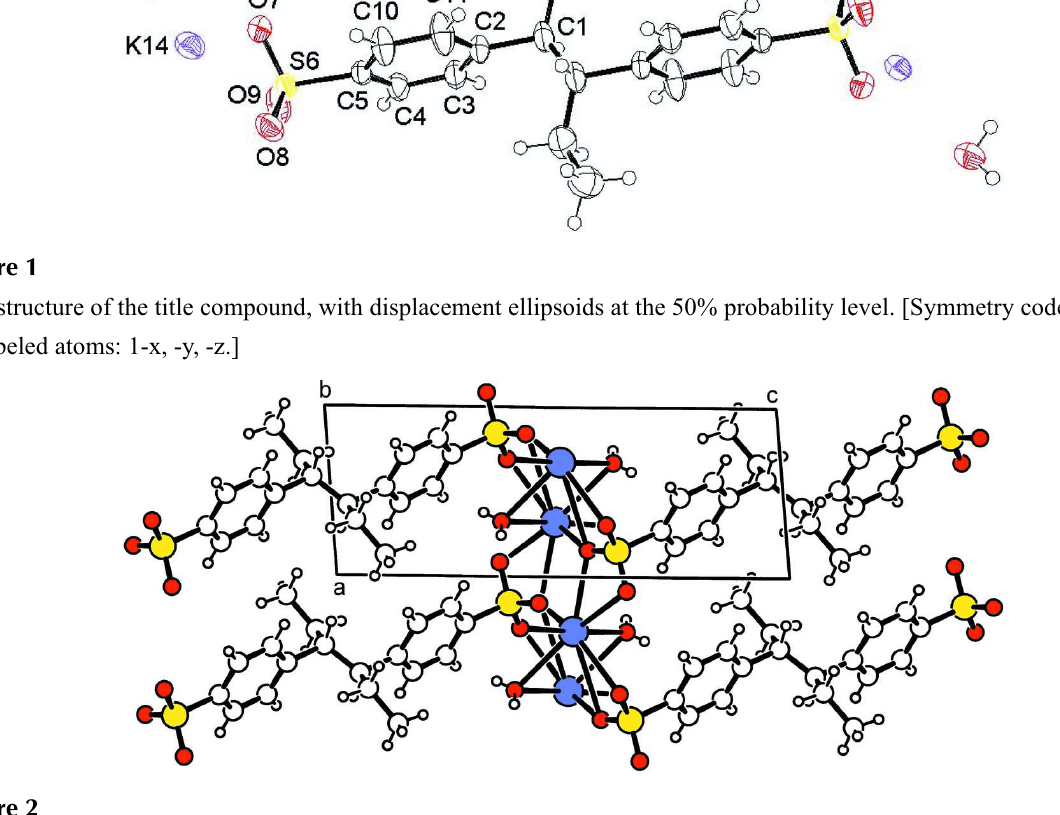
Packing diagram of the title